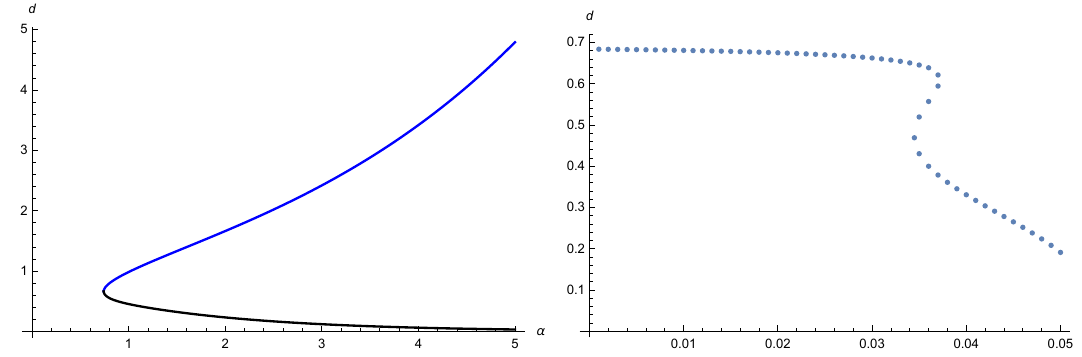
Figure 8 . On the left, we plot the fatness ratio d for blue unstable and black metastable states at p= ~ M = 0 : 03. The merger of the two branches occurs at d ’ 1. The near-extremal metastable con(cid:12)gurations are thin (small values of d ), whereas the near-extremal unstable ones are fat (large values of d ). On the right, we plot the fatness ratio d (de(cid:12)ned in eq. (6.1)) at the merger points of the metastable states as a function of p= ~ M . In region I, that involves a thin-fat merger, d is almost constant. In region III, that involves a thin-thin merger, d depends strongly on p= ~ M . The intermediate regime II involves a multiplet of merger